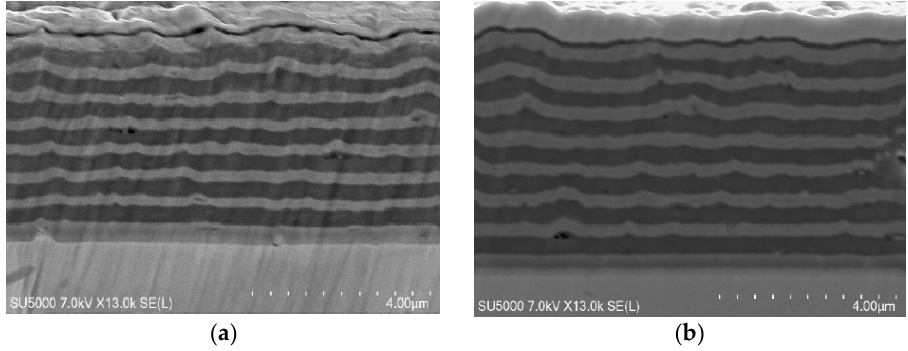
Figure 5. SEM cross-section images of as-deposited ( a ) and annealed at 900 °C ( b ) CrAlSiN-AlSiN